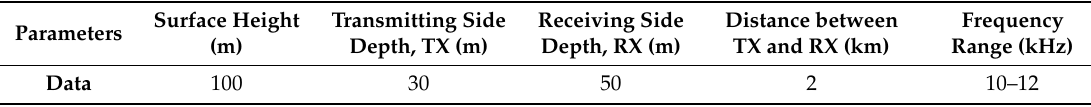
Table 2. Bellhop channel configuration.